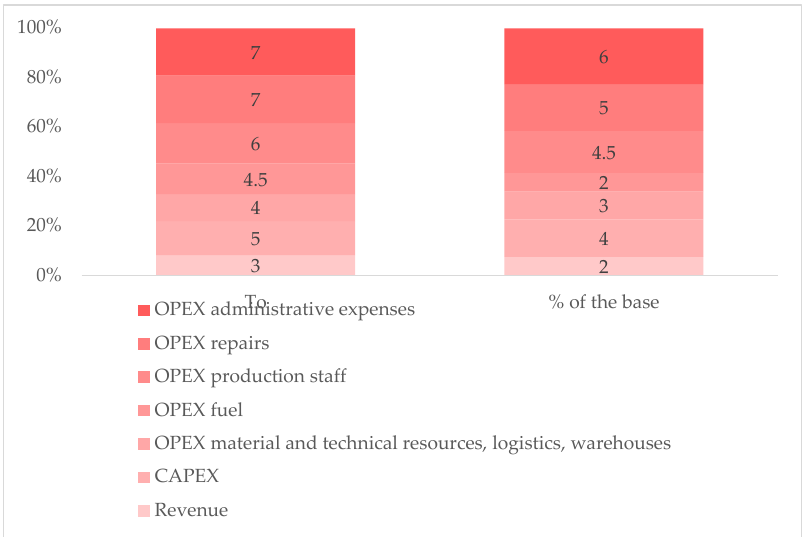
Figure 11. Estimated economic effect of the introduction of digital solutions (on the example of some enterprises), with the indicator before implementation and the indicator “% of the base” [59]. Based on the presented data, there is an increasing need to create a fully digitalized